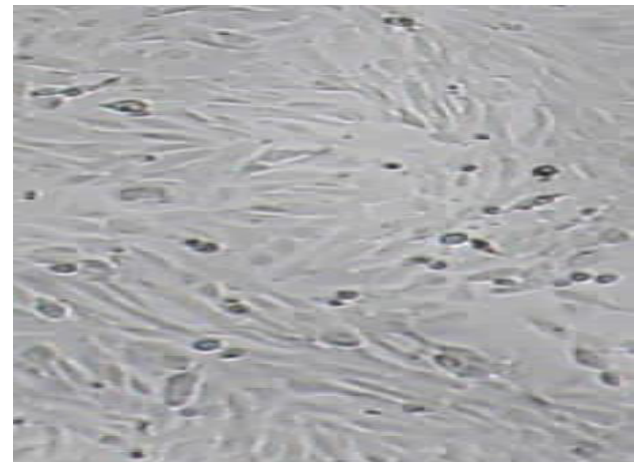
Figure 1: secondary fetal ovine thyroid cell (control) 10 X